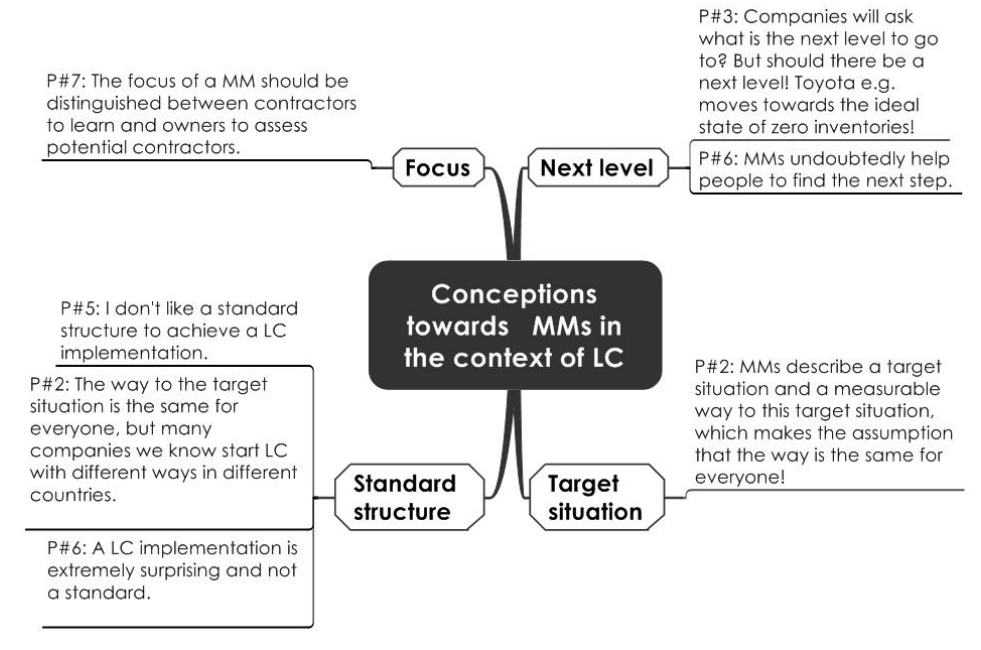
Figure 4 Concepts of maturity